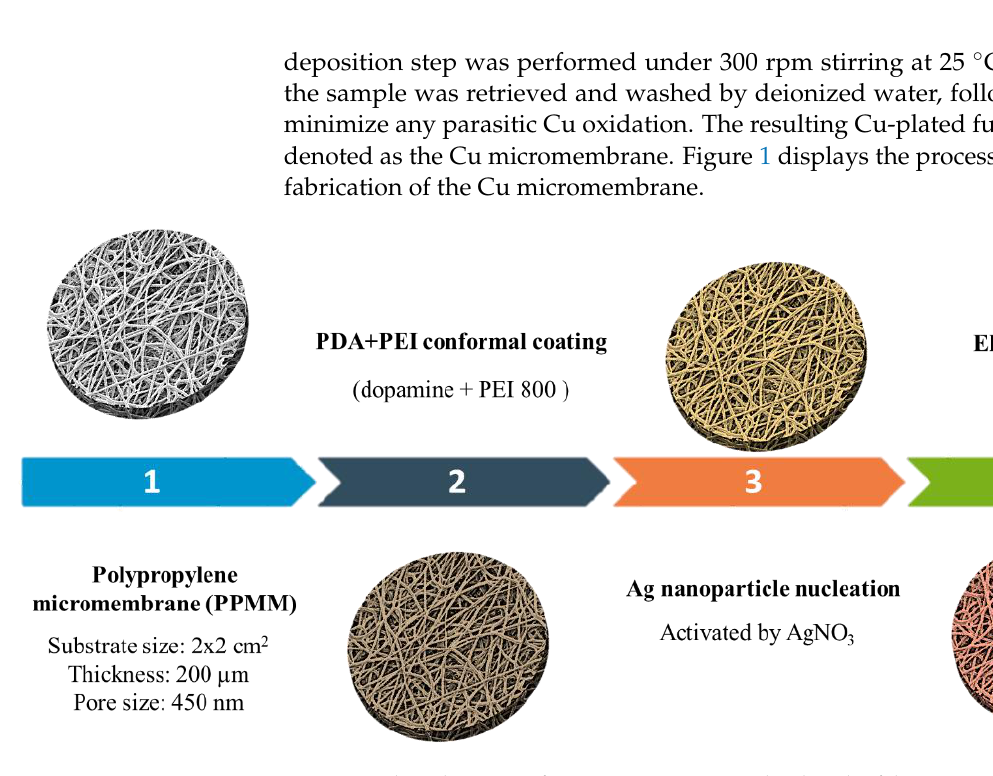
Figure 1. The schematic of processing steps involved in the fabrication of the Cu micromembrane.